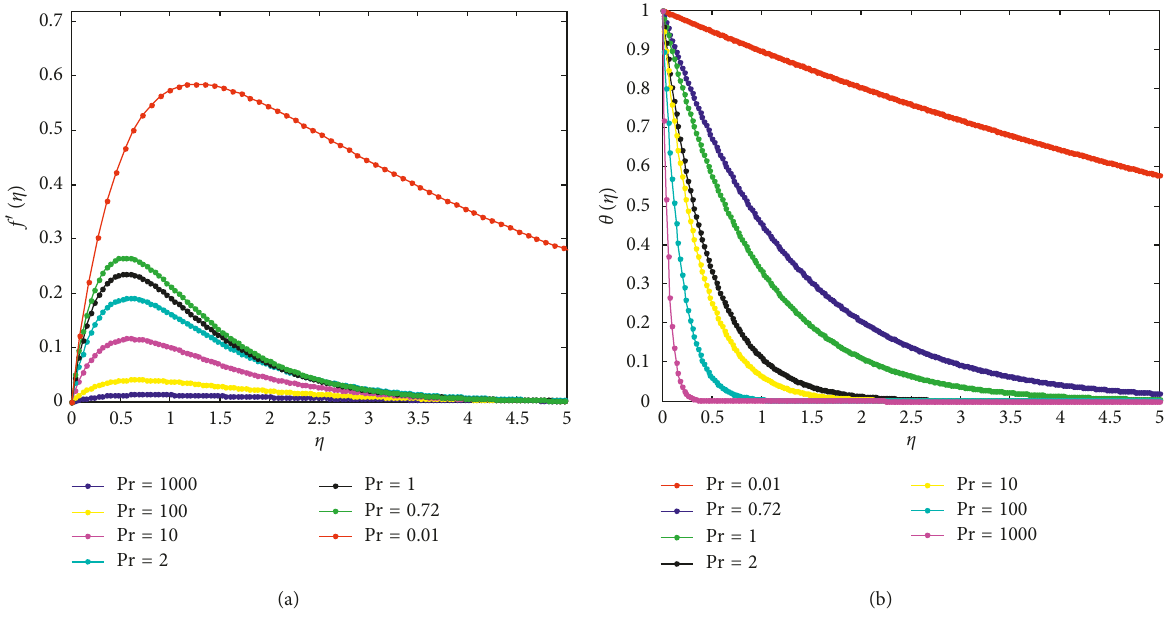
Figure 17: (a) Effects of Prandtl number on the velocity profile for CuO nanoparticle. (b) Effects of Prandtl number on the temperature profile for CuO